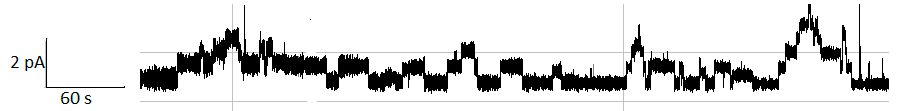
Figure 3. Planar bilayer voltage clamp trace for W- o C 6 H 4 -W (3) in asolectin bilayers, applied voltage = 30 mV, 10 mM HEPES buffer, [KCl] = 450 mM.